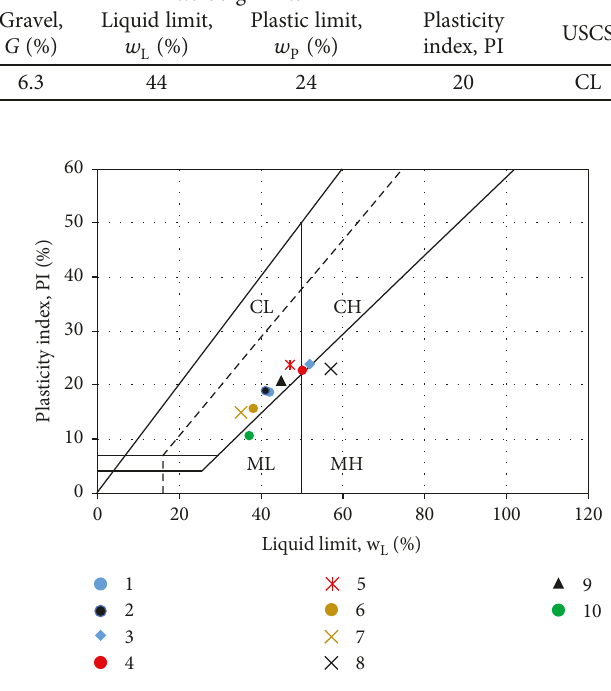
Figure 4: Plasticity chart of the